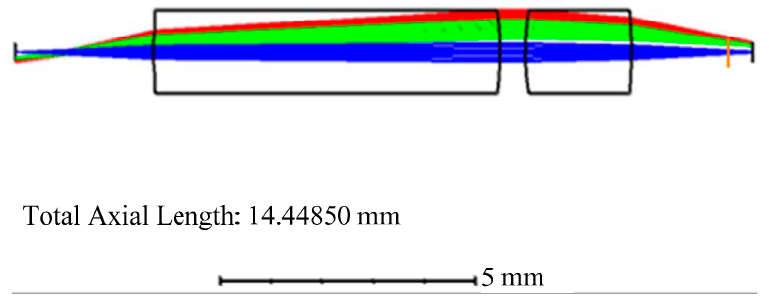
Figure 2. The optimization results with the optical parameters ( l 1 , l 2 (cid:48) , l 1 , l (cid:48) 2 , and M ) = ( − 2.704 mm, 1.9055 mm, − 1.643 mm, 105.436 mm, and − 3.463) based on rule 1.